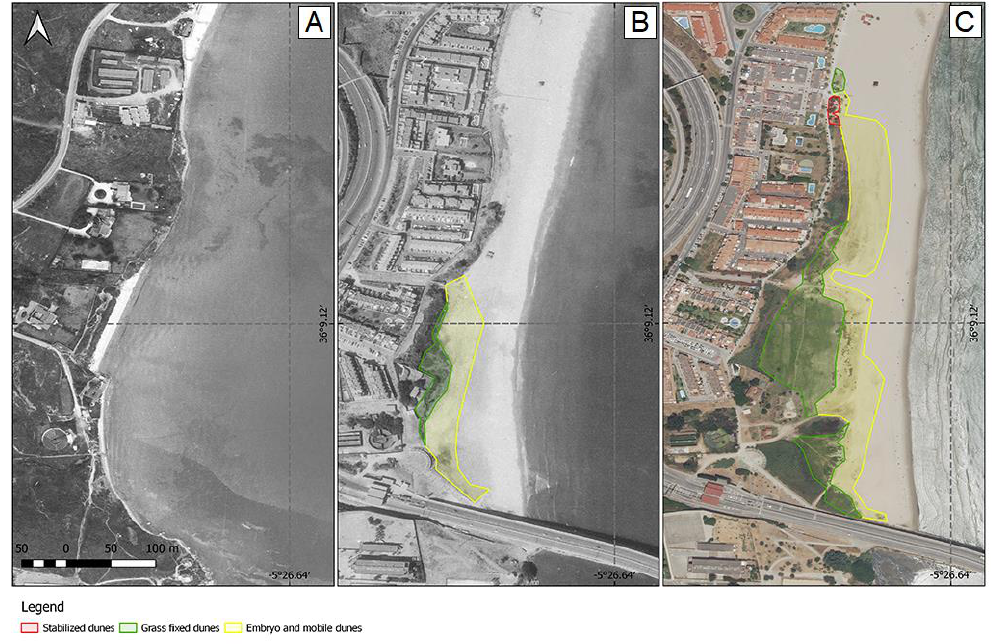
Figure 8. System no. 2 Playa del Rinconcillo registered an increase of dune surface of 732.26 m 2 in